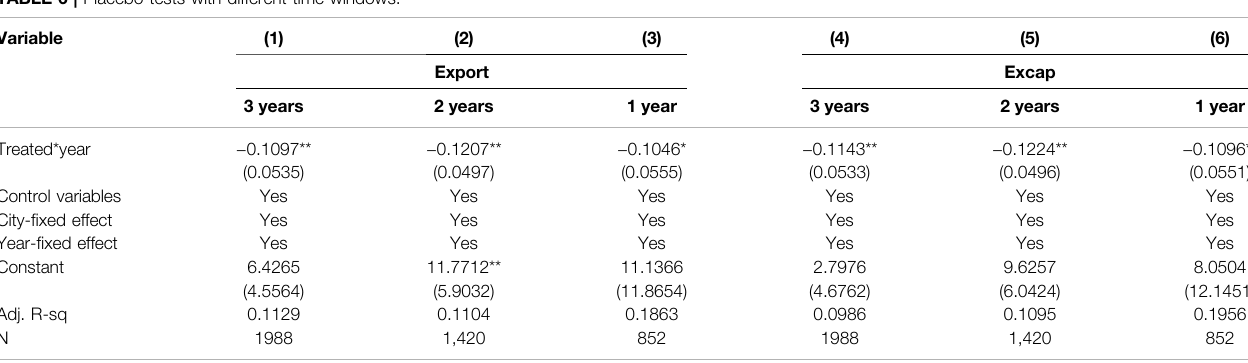
TABLE 6 | Placebo tests with different time windows.